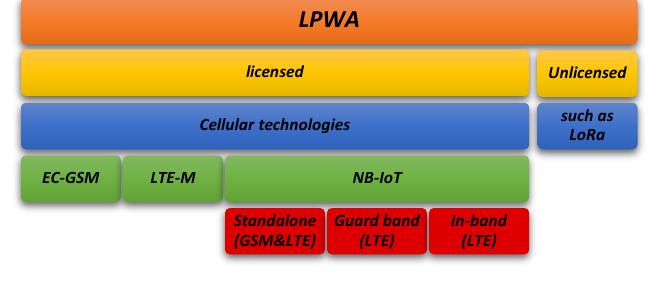
Figure 6: LPWA technologies